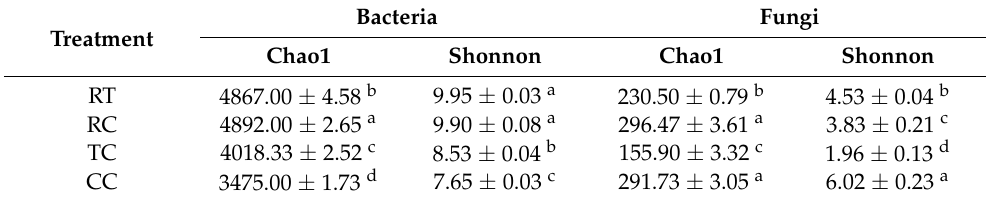
Table 3. The α -diversity of rhizosphere microbial in four planting patterns.